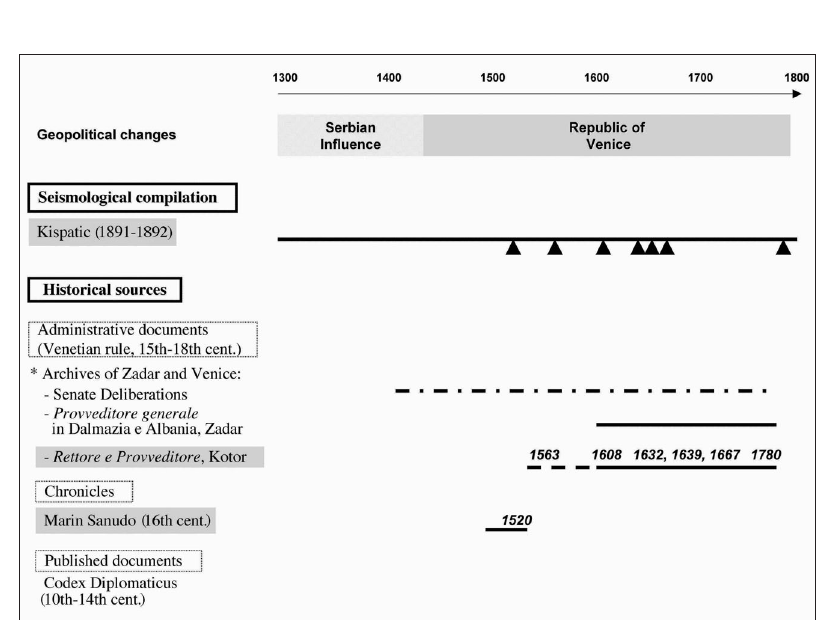
Fig. 4. Kotor: seismic and historical background. Major earthquakes described by Kispatic (1891-1892) are ev- idenced on the timeline by triangles. Earthquake dates are shown on the time interval spanned by the historical sources (shaded boxes) supplying the record to Kispatic. Other sources are those available for Zadar and not sys- tematically investigated so far.